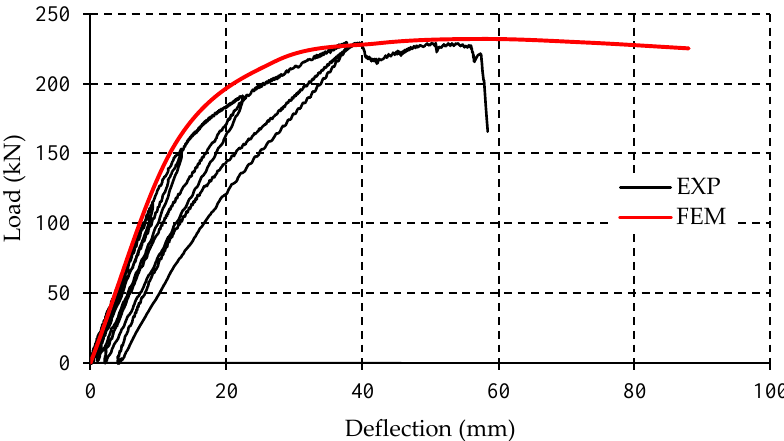
Figure 10. Validated ultimate load for the loaded girder G1.